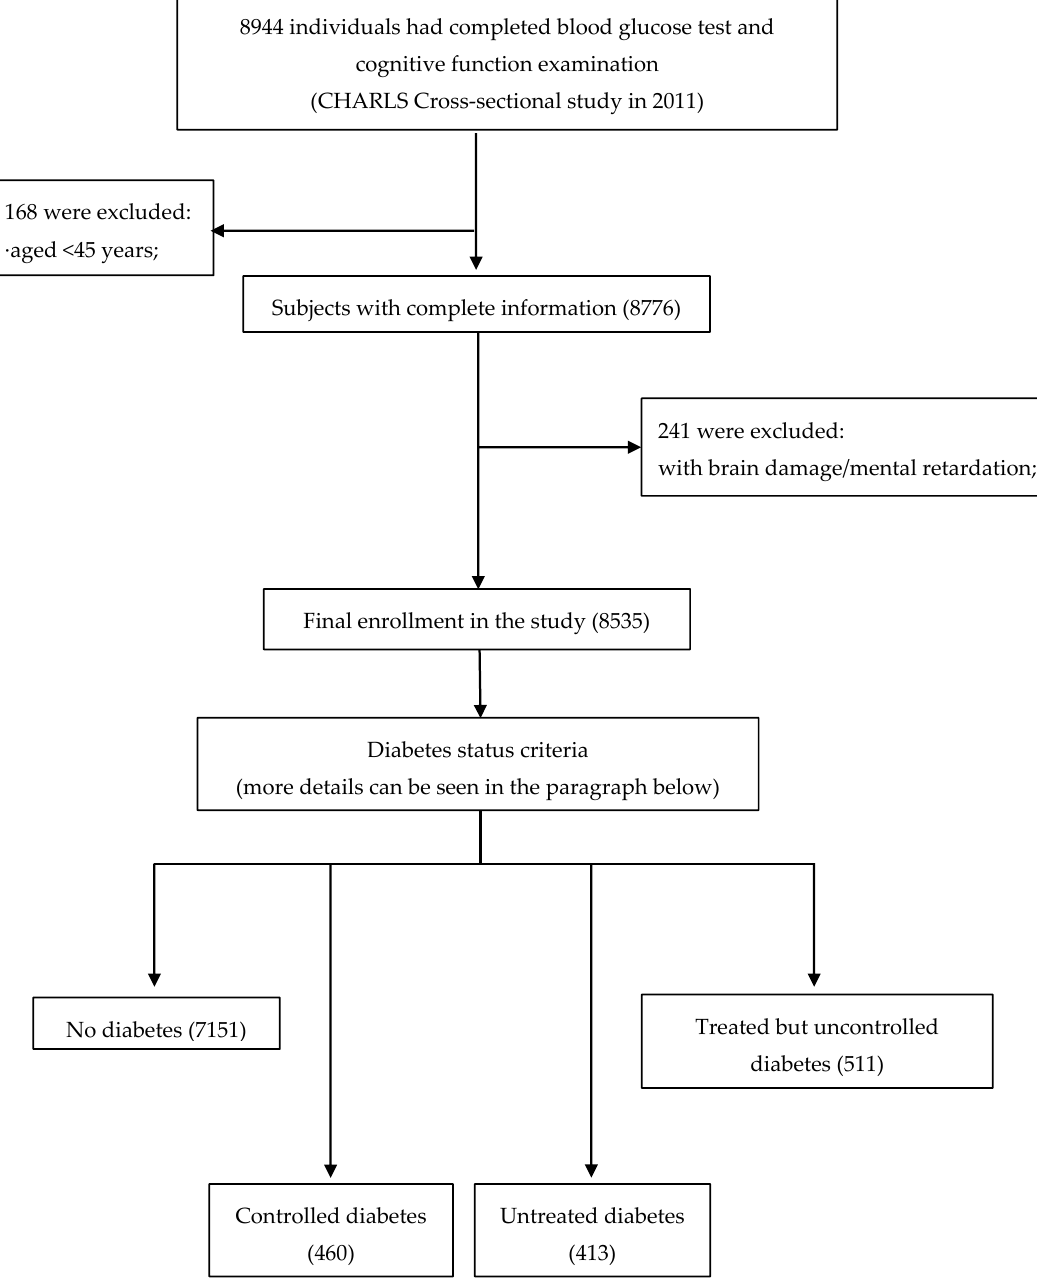
Figure 1. Flow diagram of the study population in the project.